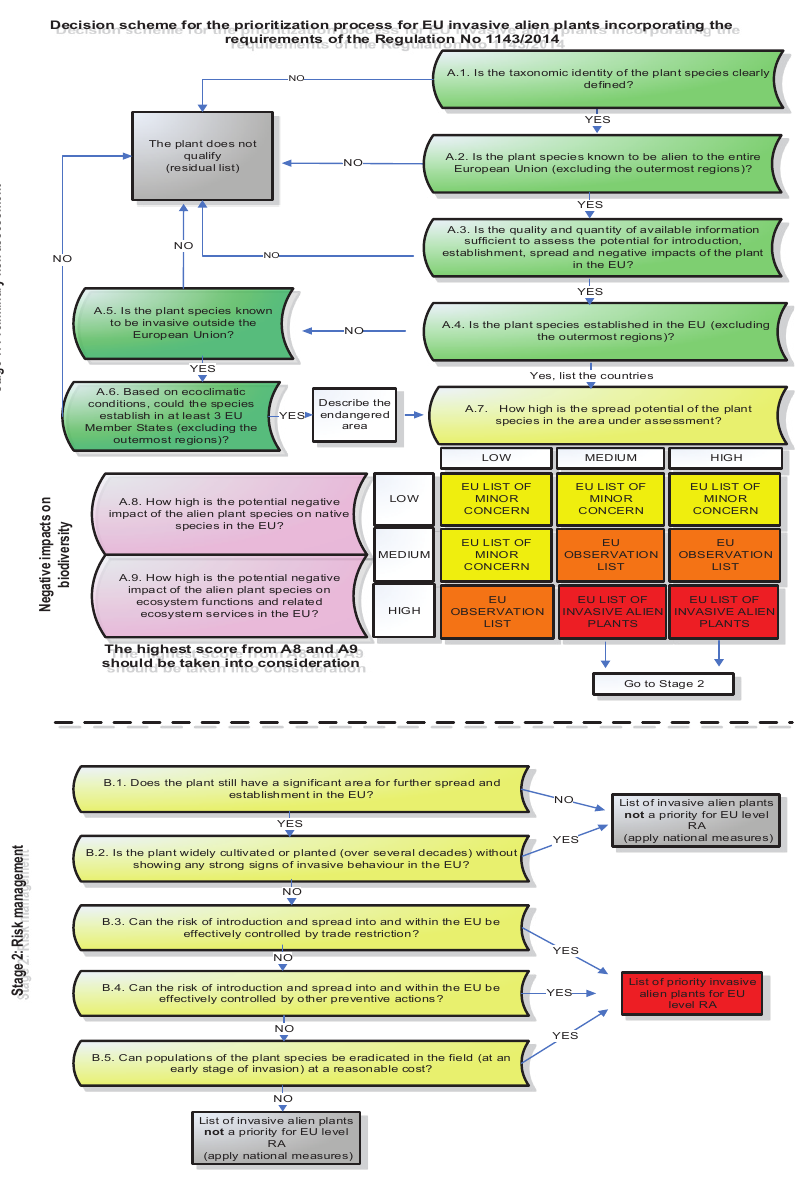
Figure 1. Decision scheme for the EU prioritisation process for alien plants (Taken from Branquart et al.